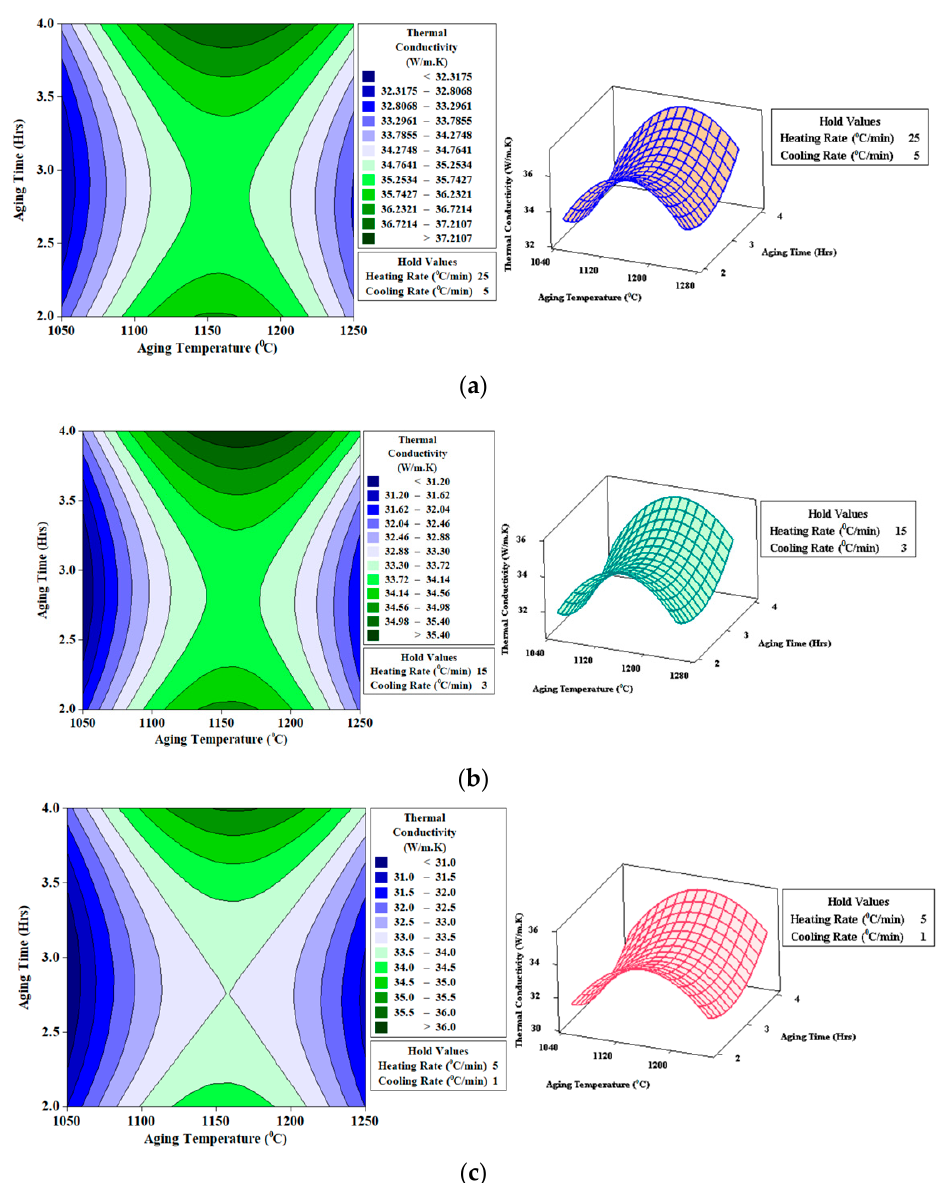
Contour and surface plots for electrical conductivity ( Ω − 1 m − 1 ) presented in Figure 16a, clearly show that maximum thermal conductivity (36.7214–37.2107 W/m.K) can be achieved with aging temperature (1150 °C), aging time (four hours), heating rate (25 °C/min), and cooling rate (5 °C/min).